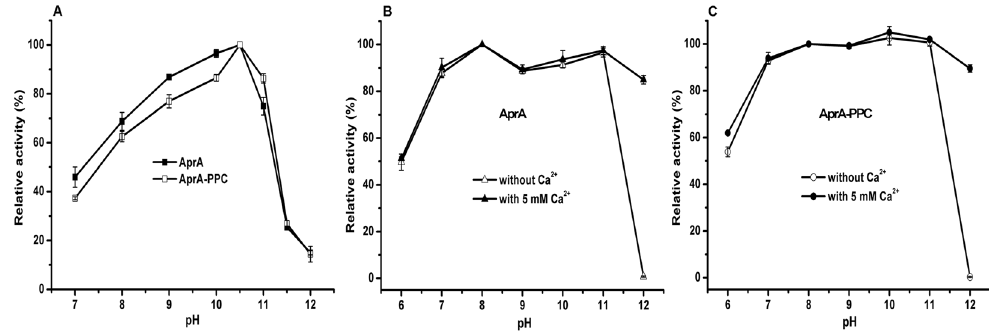
Figure 5. Effects of pH on AprA and AprA-PPC activity and stability with or without Ca 2 + . ( A ) The optimal pH for AprA activity ( filled square ) and AprA-PPC activity ( empty square ) without Ca 2 + ; ( B ) pH stability of AprA with ( filled triangle ) or without ( empty triangle ) Ca 2 + ; ( C ) pH stability of AprA-PPC with ( filled circle ) or without ( empty circle ) Ca 2 + . The measurements were performed in three independent experiments. Error bars represent standard